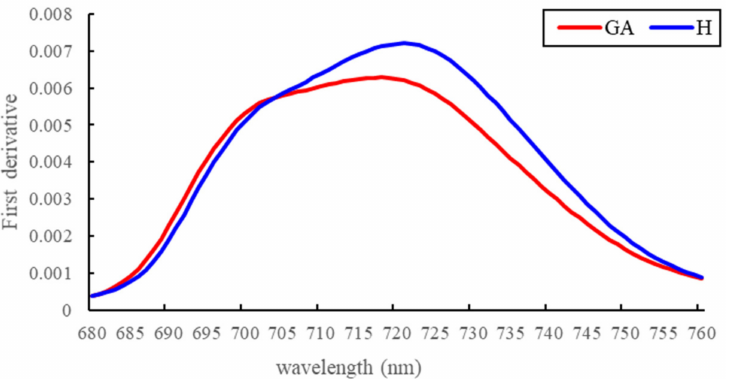
Figure 6. First derivative of mean reflectance in red-edge region (680–760 nm).